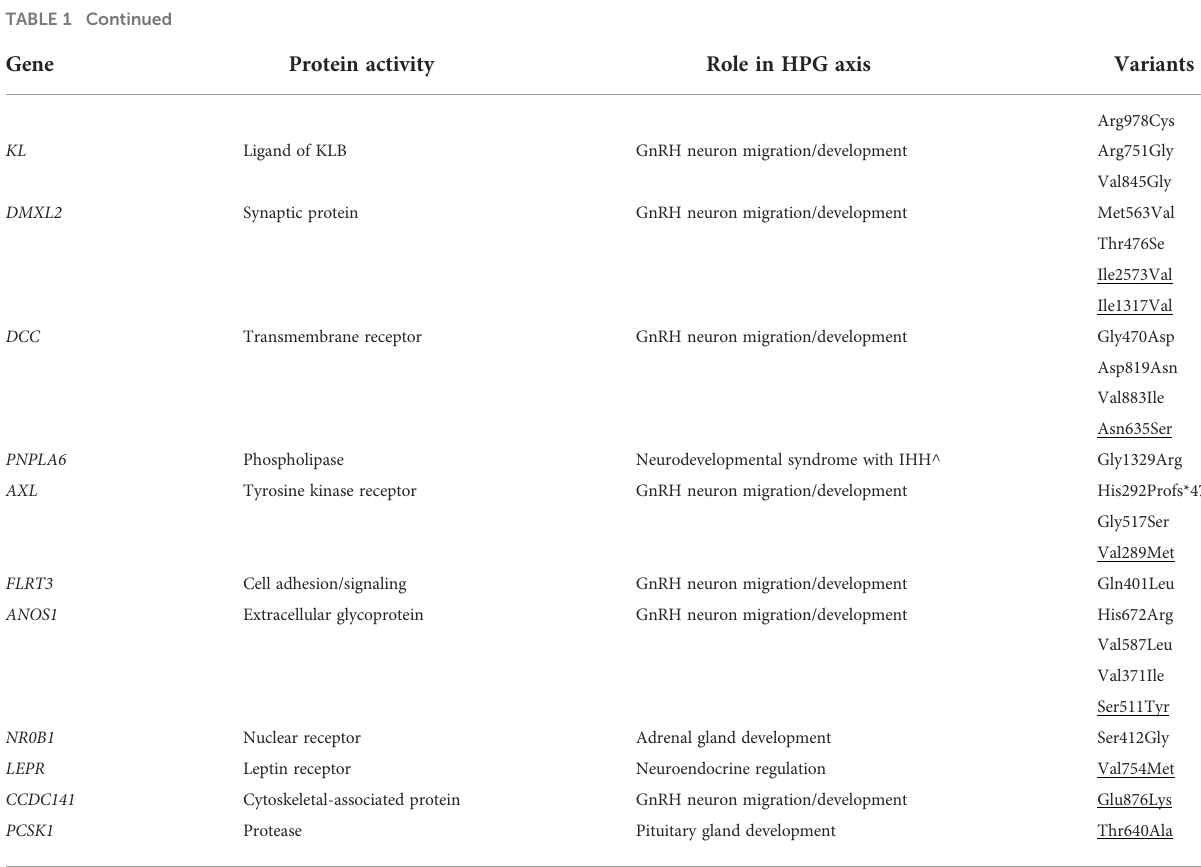
(Table 2). Other signaling pathways, involving a cross- regulation of satiety and estrogen production, including the serotoninergic and leptin pathways, have been linked to an increased risk to develop AN. Common variants in the OPRD1 , HTRD1 , EBF1 and SLC6A4 genes show a higher frequency in AN patients compared to controls and